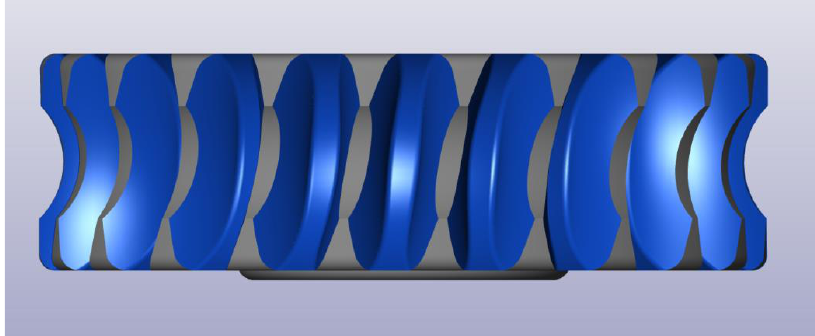
Figure 8. 3-dimensional CAD model of worm wheel.